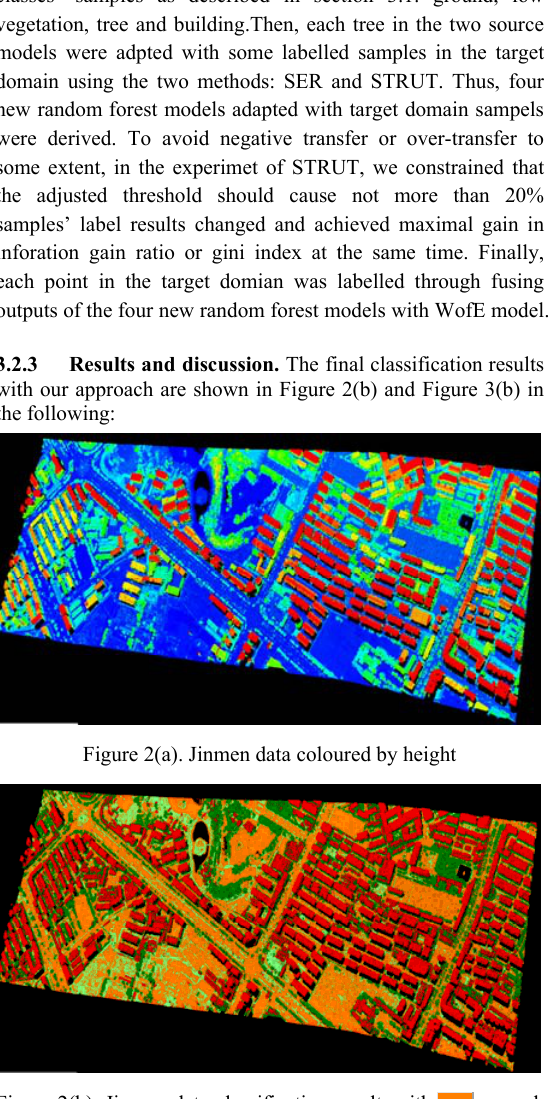
Figure 2(b). Jinmen data classification result, with: ground, low vegetation, tree, building